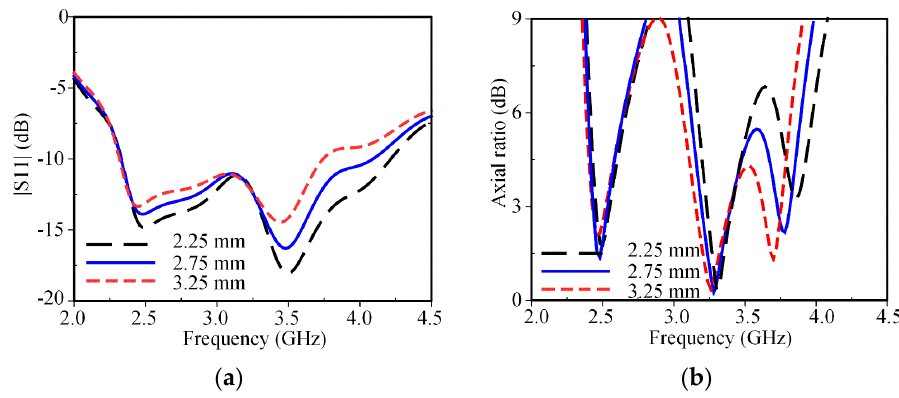
Figure 8. Effect of H 2 on antenna performances: ( a ) S11; ( b ) axial ratio. Figure 8. E ff ect of H 2 on antenna performances: ( a ) S11; ( b ) axial